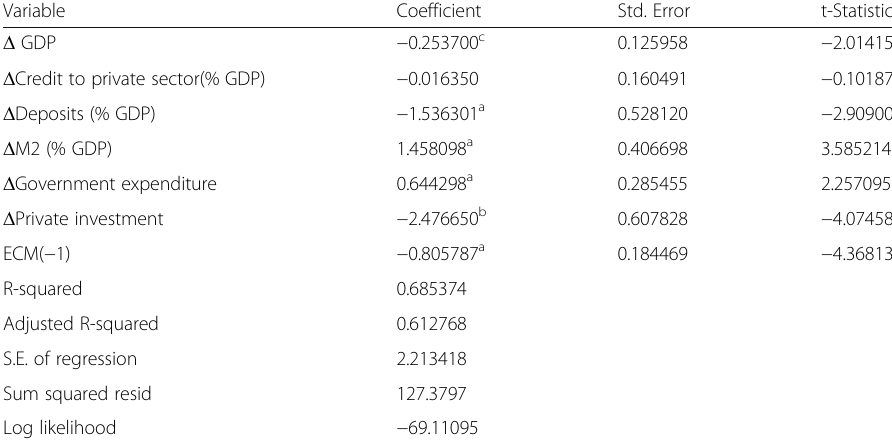
Table 7 Short- run impact of financial development on economic growth Variable Coefficient Std. Error